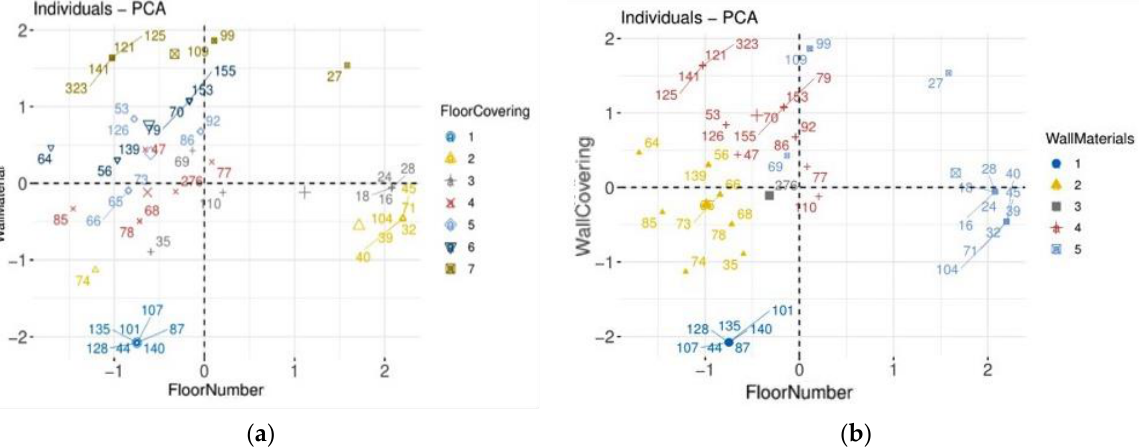
Figure 8. Factor maps of the first analysis with differentiated individuals according to ( a ) floor covering (1 = Majolica, 2 = Wood, 3 = Linoleum, 4 = Carpet, 5 = Granite, 6 = Marble, 7 = Other) and ( b ) wall materials (1 = Cement, 2 = Bricks, 3 = Stones, 4 = Tuff, 5 = Other). Floors covered with tiles are all positioned in the third quadrant, and are